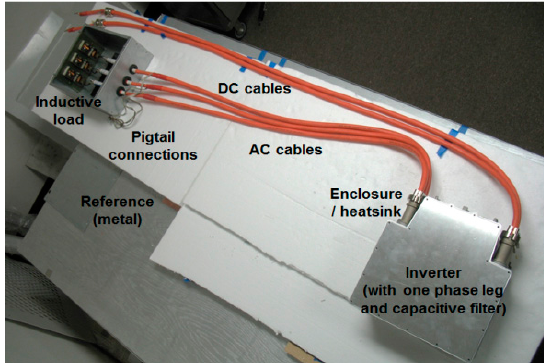
Figure 2. Test platform for power inverter drive system.